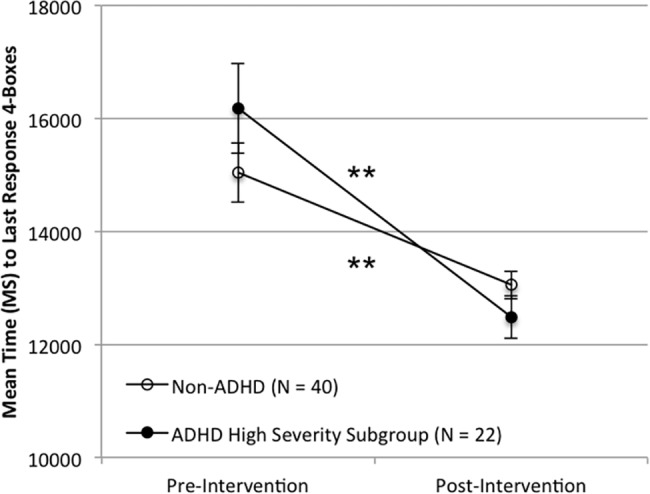
Performance on the spatial working memory task pre- and post-intervention for the ADHD High Severity subgroup and the non-ADHD group.Note. Scores represent mean time to last response with 4 boxes. Error bars represent standard error of the mean. (** p < 0.005).